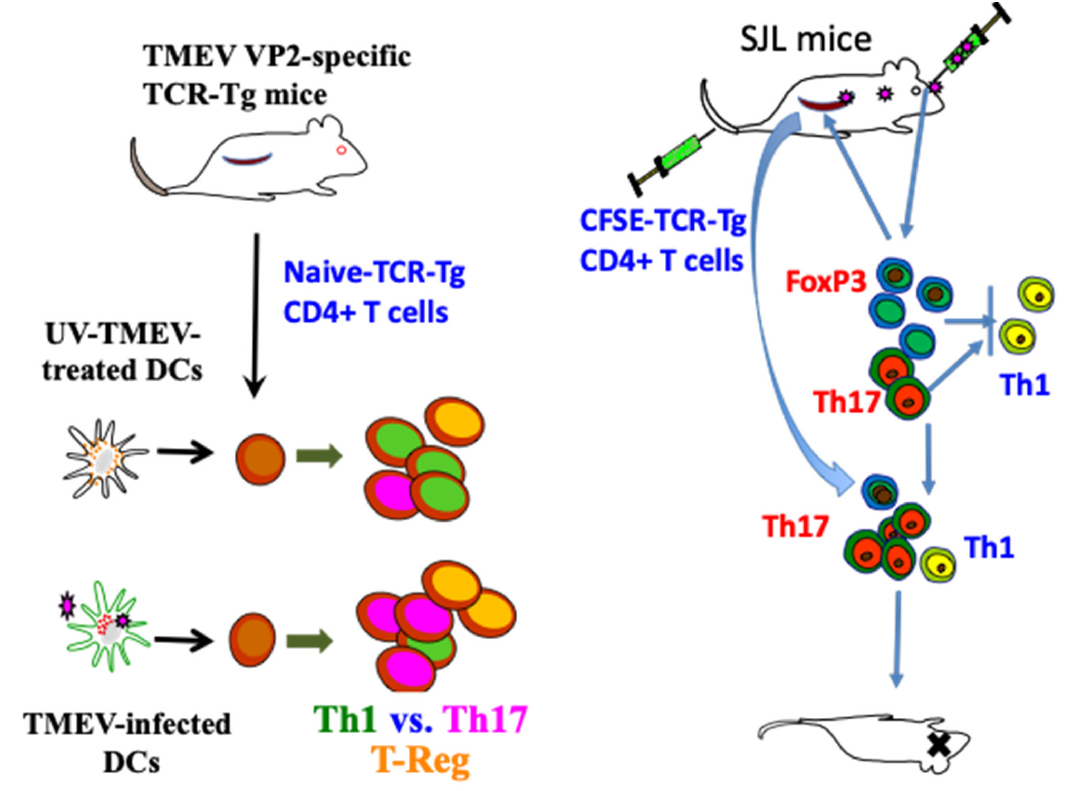
Figure 4. Utilization of TMEV VP2 72–86 -specific TCR-Tg mice in analyzing the development of CD4 + T cell subpopulations during TMEV infection [65,136]. These signals induce the production of IL-1, IL-6, IFN α / β , and TGF- β , which promote elevated induction of pathogenic FoxP3 + T-reg, Th17, and Tc17. Furthermore, IL-6 and IL-17, in addition to Tim and PDL-1, synergistically inhibit protective CD8 + T lymphocytes (CTL) function [107]. IFN α / β inhibits Th1 responses and elevates the expression of costimulatory molecules on antigen-presenting cells (APCs), which in turn promotes the induction of Th17 responses